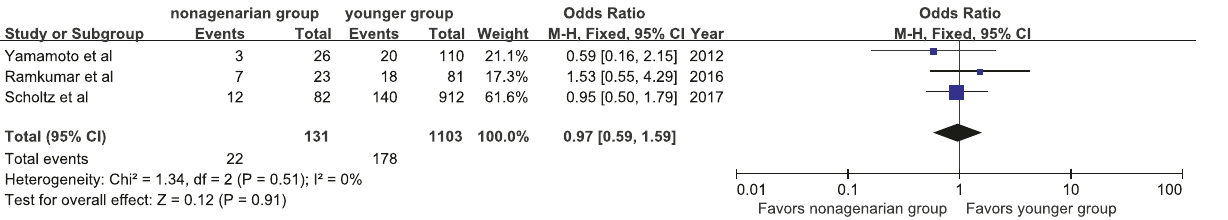
Figure 11: Forest plot of pooled analysis comparing the rates of new pacemaker implantation in nonagenarians versus younger patients.